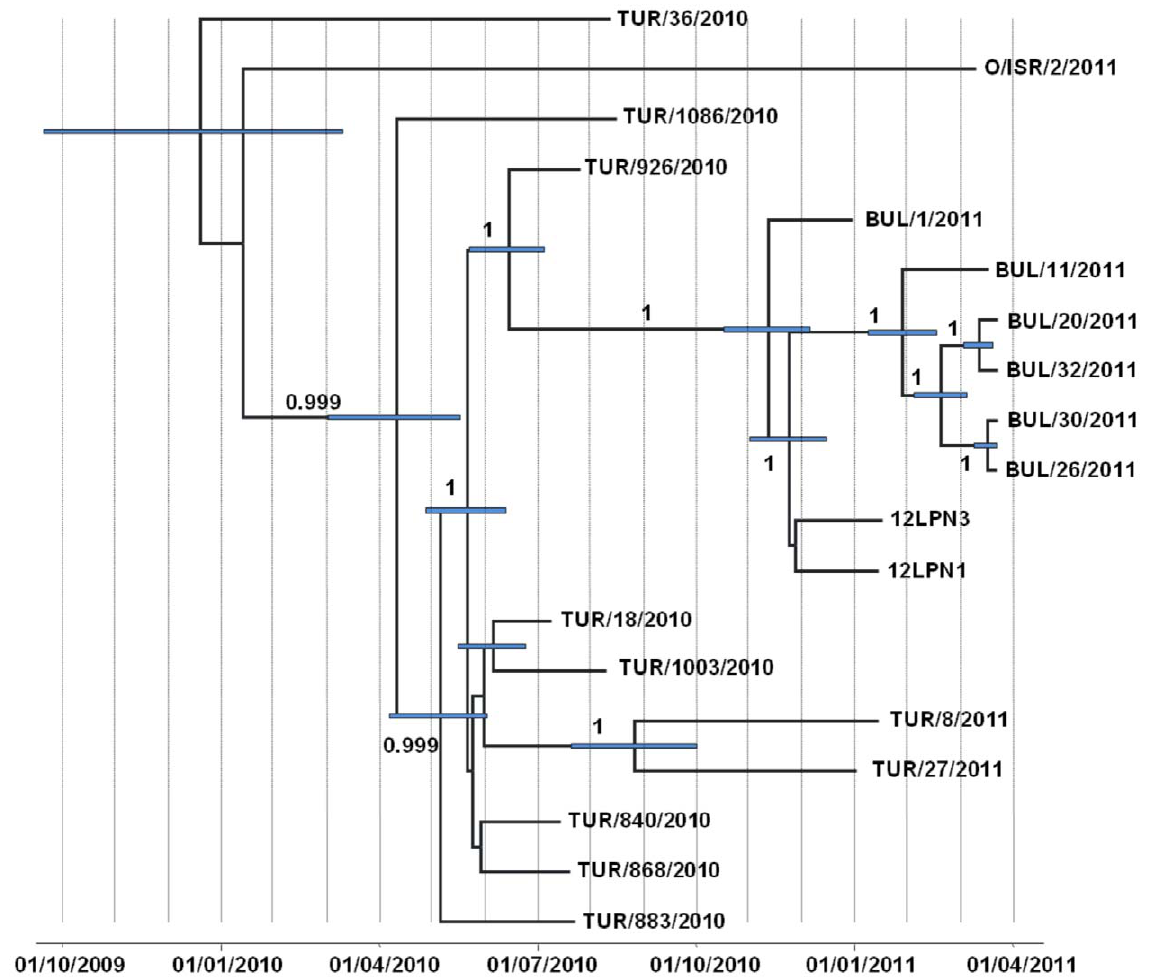
Figure 4. Bayesian maximum-clade-credibility time-scaled phylogenetic tree (BEAST) generated using 19 sequenced FMDV full genomes. The analysis was undertaken using a GTR substitution model, relaxed clock, constant population size, sampling 30.000 trees from 30 million generations. Uncertainty for the date of each node (95% highest posterior density – HPD - intervals) is displayed in bars. Only node labels with posterior over 0.8 are indicated. Overall, a rate of nucleotide substitution of 9.05 6 10 2 3 (95% HPD: 6.99–11.11 6 10 2 3 ) per site per year was estimated.